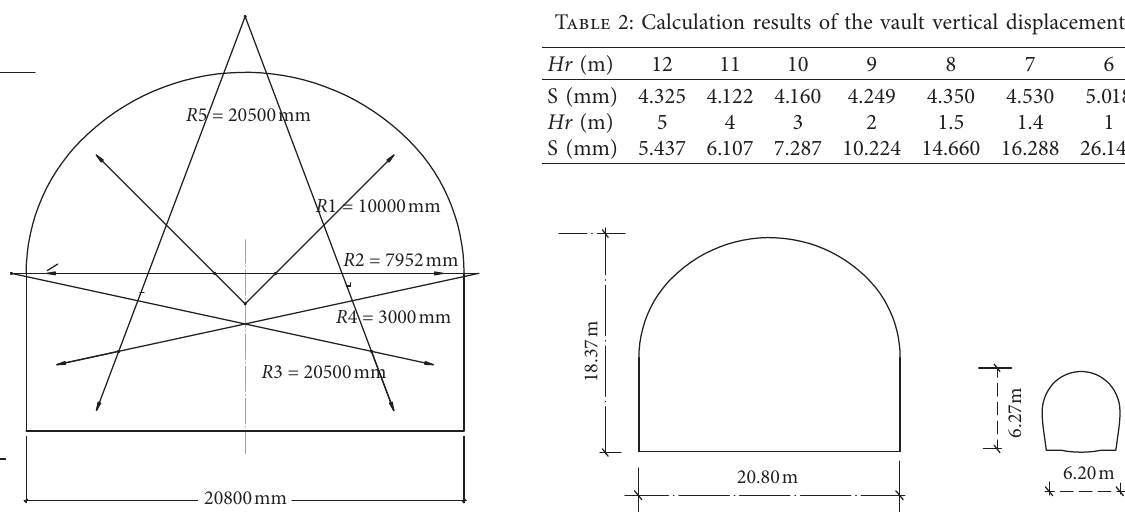
Figure 5: Metro tunnel section type and